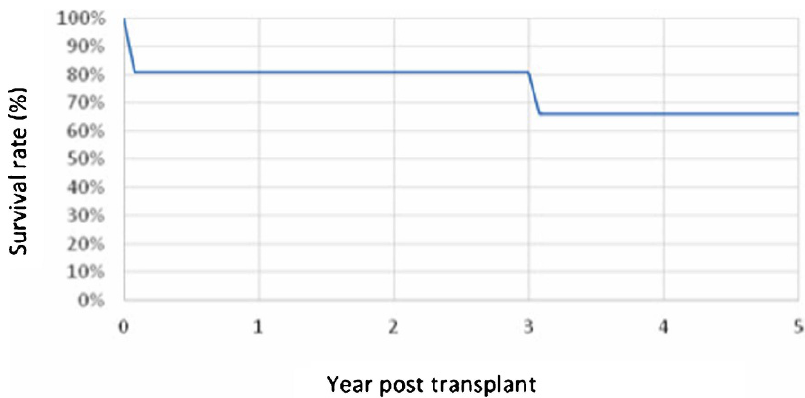
Figure 2 - Survival Curve – Kaplan Meier.